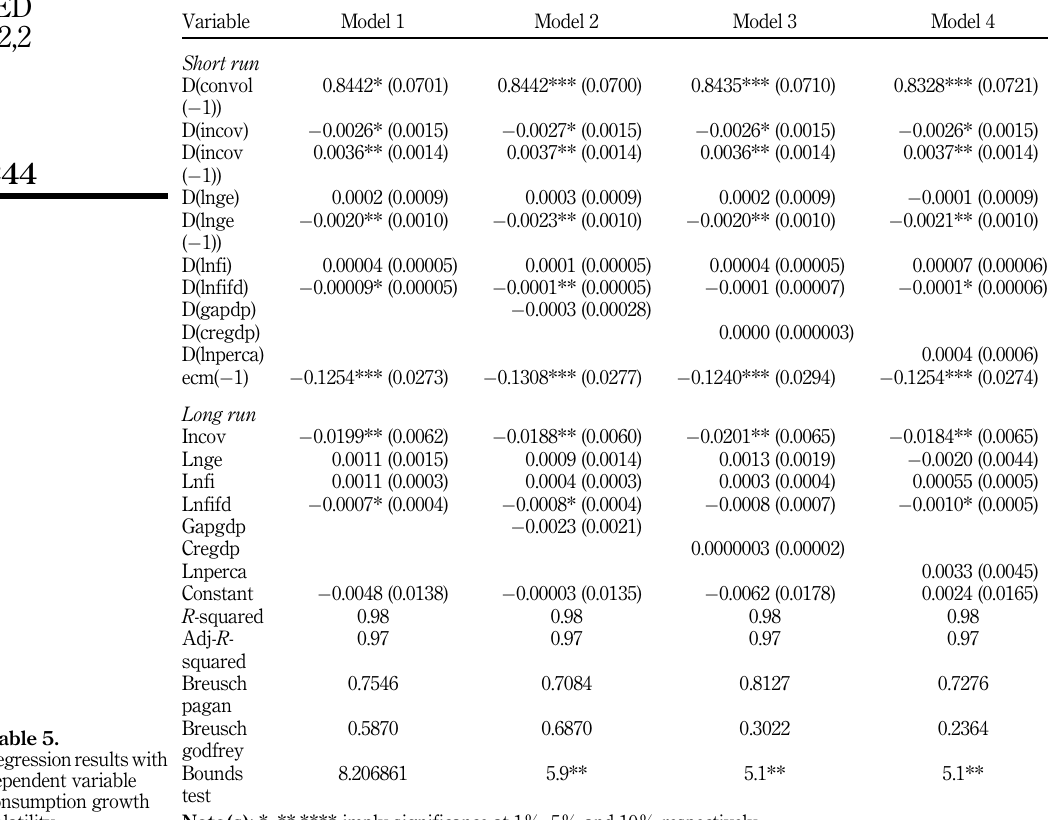
Table 5. Regressionresultswith dependent variable consumption